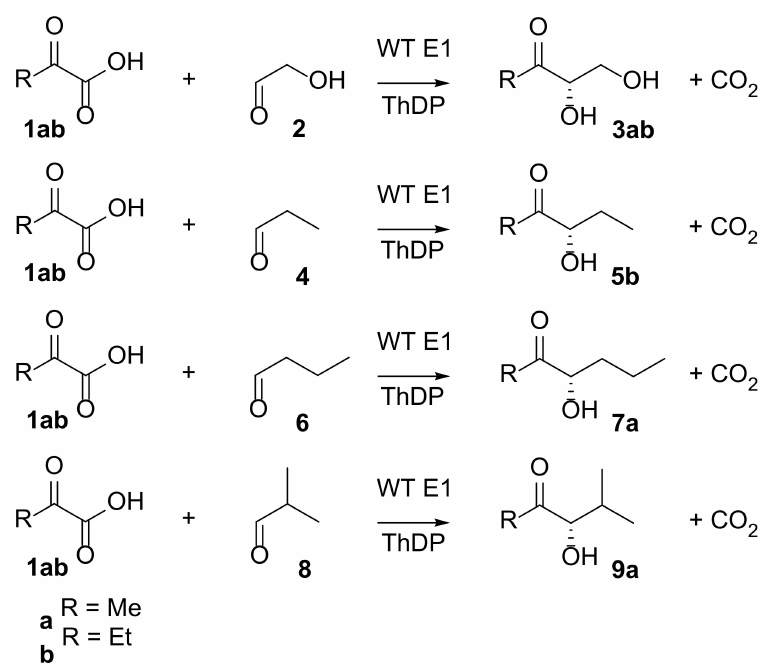
Scheme 2. Preparative scale (0.6–10 mmol) coupling of ketoacids 1ab with various aldehydes to a ff ord the corresponding ( S )-configured acyloins under kinetically controlled